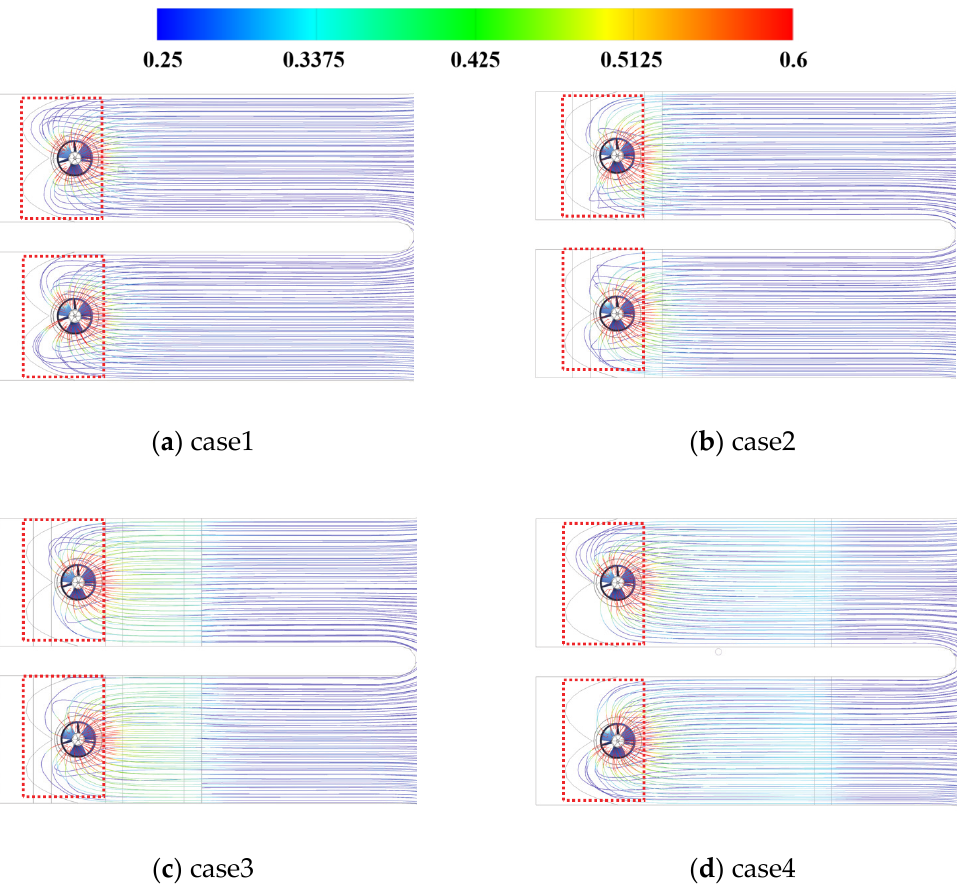
( d ) case4 Figure 6. Contour of velocity distribution in longitudinal profile of the sump. 4.2.2. Flow state analysis of bell mouth The bell mouth is the only channel for water flow into the pump in the sump, so the flow state at the bell mouth directly affects the performance of the pump. Figure 7 shows